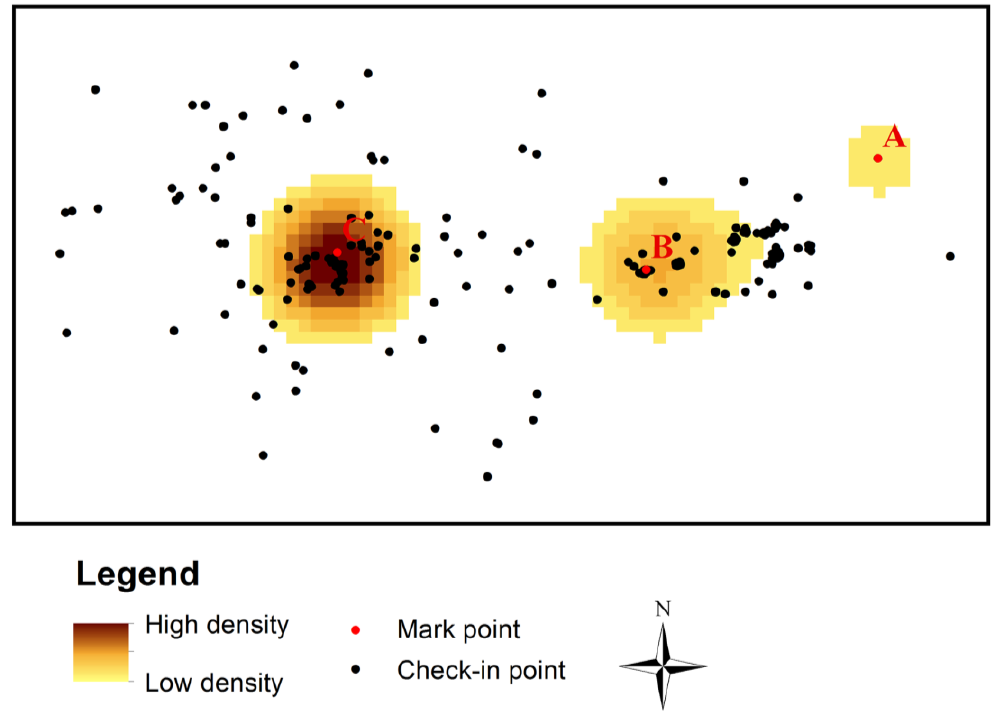
Figure 3. The areas with high point density.